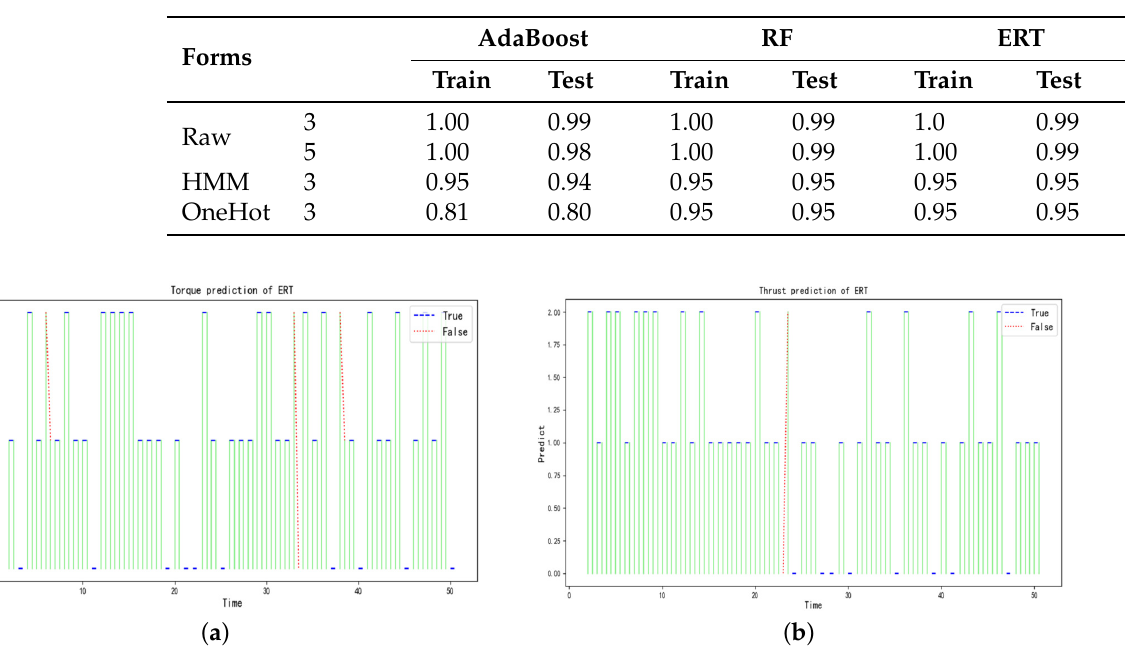
Table 9. The A cc of models for the thrust prediction in different forms.